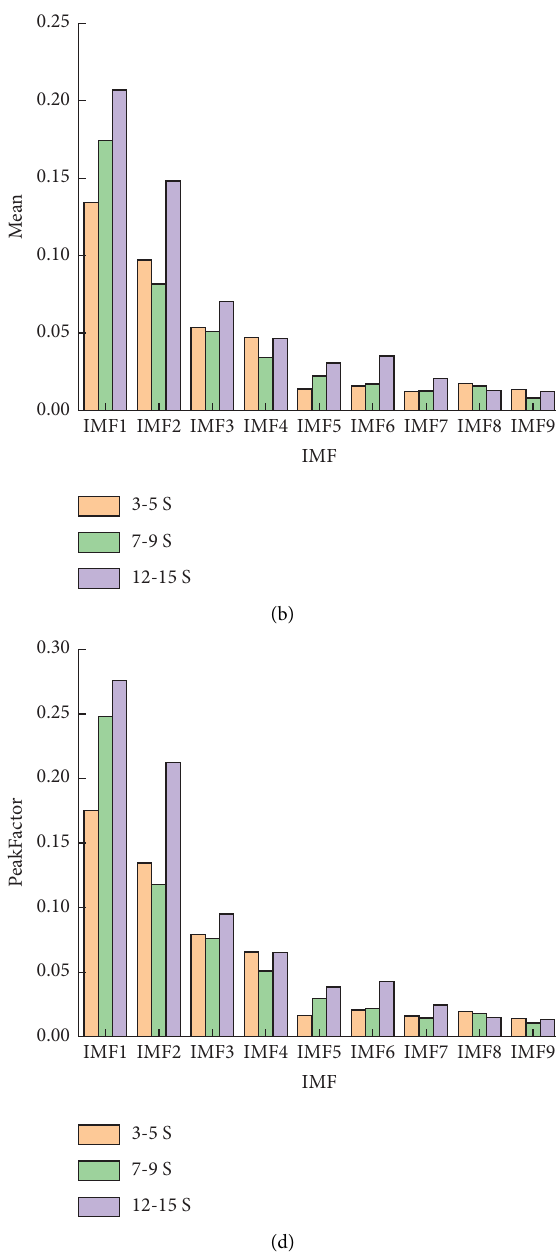
Figure 16: Eigenvalues of the IMF components of acceleration signals at diferent